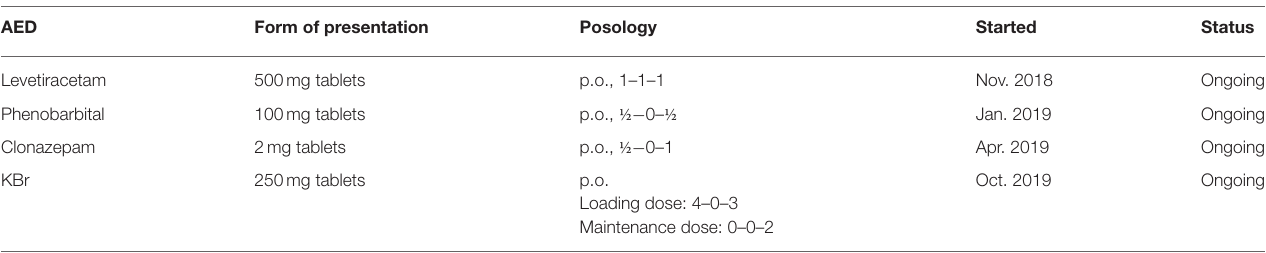
TABLE 1 | Treatment protocol of Case No.